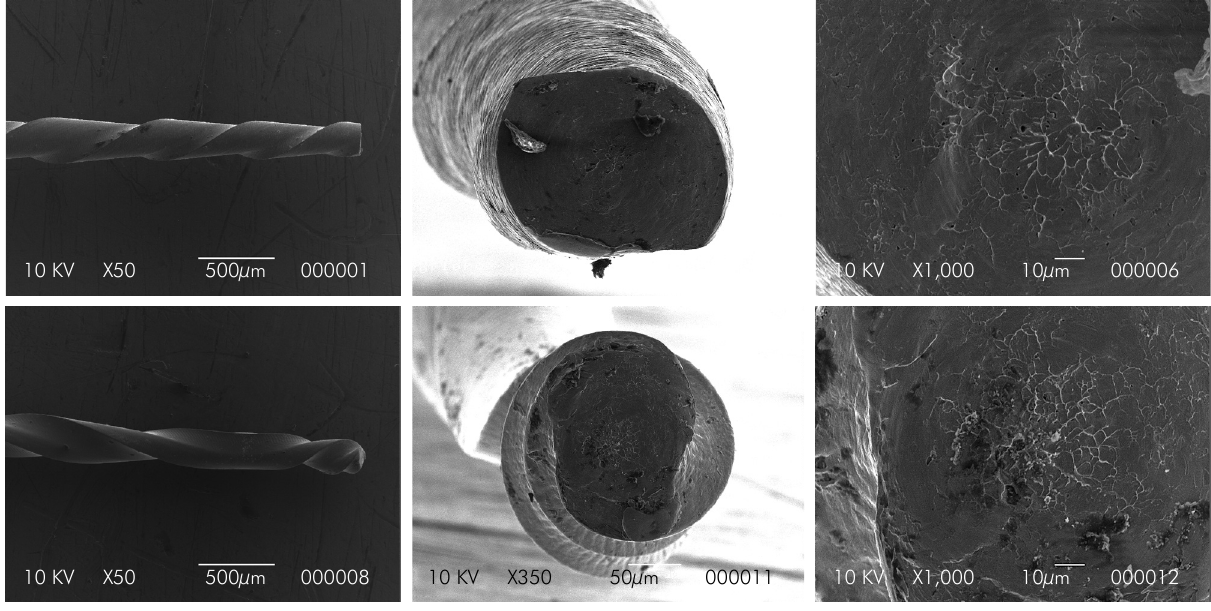
Figure. SEM images of fractured surfaces of R-Pilot (A, C, E) and of One G (B, D, F) after torsional fatigue testing. The first column shows the front view of the fracture surface of the instruments at 350X magnification; the second column shows the center of rotation with the concentric abrasion mark and skewed dimples at 1000x magnification, which are typical features of torsional failure; the third column represents the lateral view of the instruments at 50X magnification, showing the plastic deformation of the spiral flutes, especially of One G